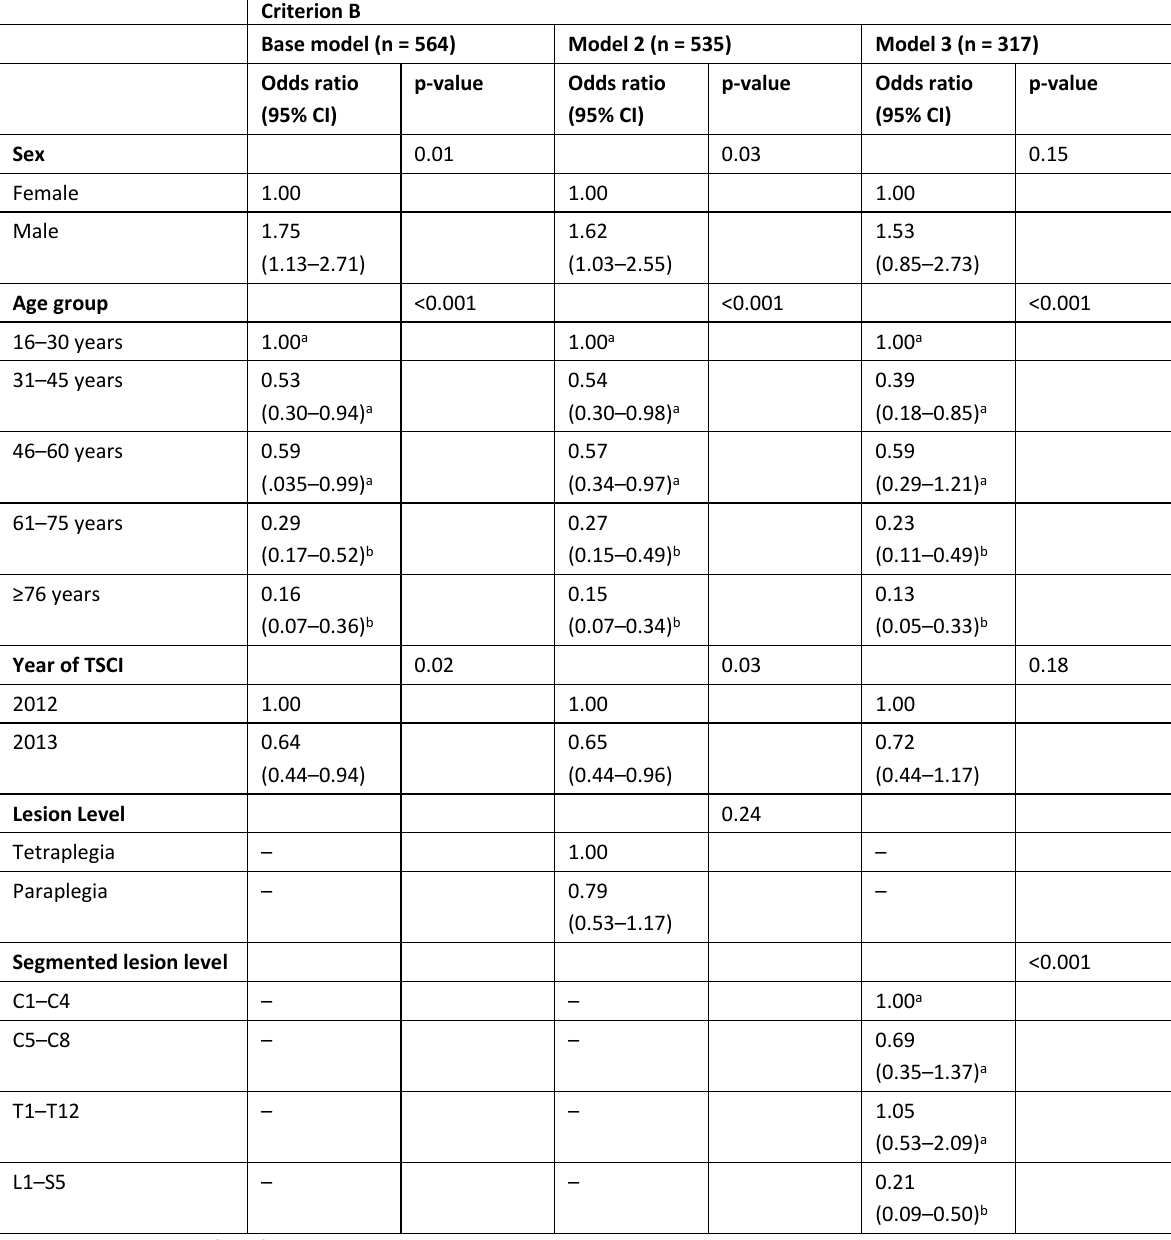
Table 4: Logistic regression of characteristics associated with discharge to a specialised rehabilitation